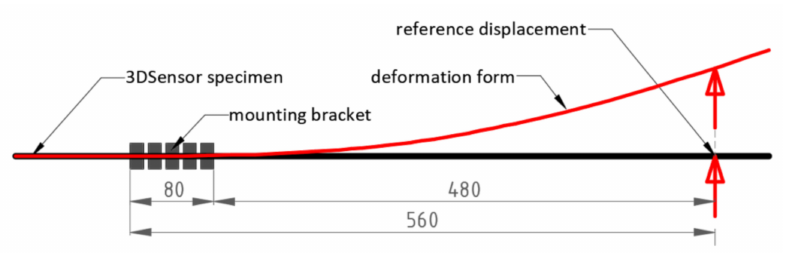
Figure 13. Static scheme of the analysed short-length